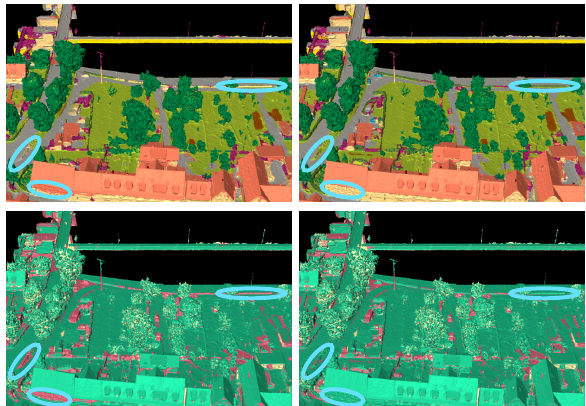
Figure 1. The top shows prediction results achieved with feature vector compositions FS 𝑑 ( left , mesh features only), and FS 𝑗 ( right , multi-modal features) (cf. Table 1) on the mesh in the lock area of Hessigheim 3D (H3D). The official class color code of the benchmark has been used throughout the paper (Kölle et al., 2021). The bottom shows the respective red-green plots indicating correct ( green ) and false ( red ) predictions. Faces with unknown ground truth are marked in yellow . The most obvious differences between the predictions are circled in skyblue